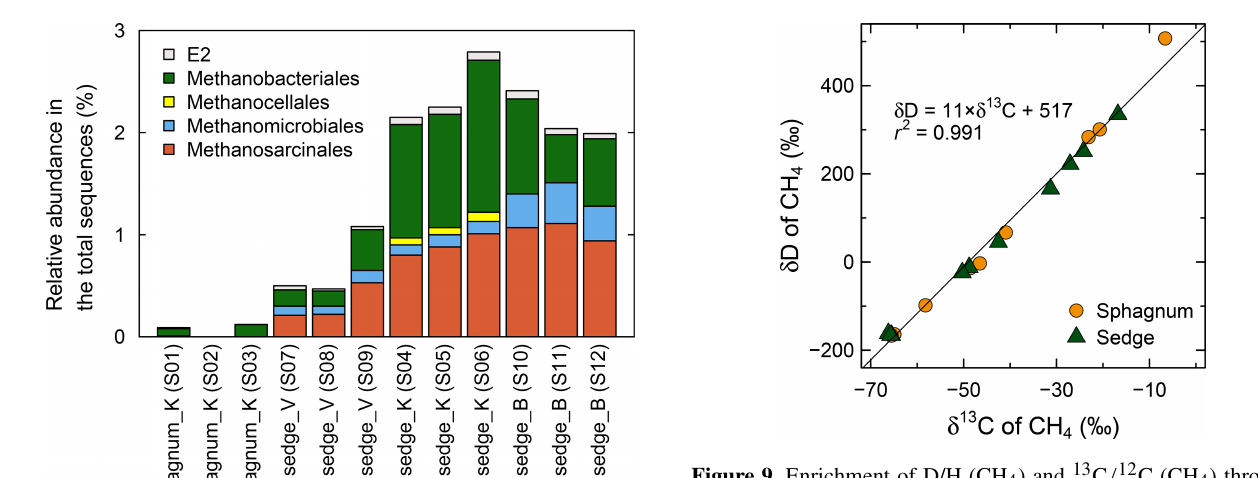
Figure 9. Enrichment of D/H (CH 4 ) and 13 C / 12 C (CH 4 ) through CH 4 oxidation during the aerobic incubation experiment of surface organic layers from wet areas of sphagnum mosses and sedges at site K. Individual delta values of the headspace CH 4 from each in- cubated syringe and each day are shown. Initial isotopic composi- tions of the headspace CH 4 were − 66‰ to − 65‰ for δ 13 C and − 167‰ to − 162‰ for δ